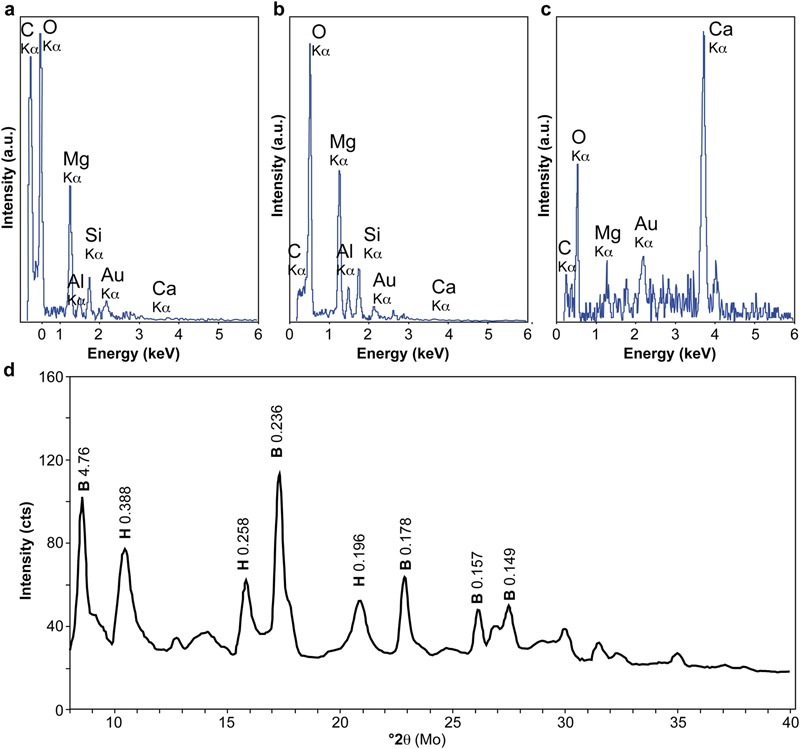
Scanning Electron Microscopy-Energy Dispersive X-ray spectroscopy (SEM-EDX) and X-Ray Diffraction (XRD) analyses of mineralized filaments from ST09 and ST07 sites. (a–c) SEM-EDX spectra of a C-rich filament (a) and encrusting O- and Mg-rich minerals (b) in ST09 samples and of secondary Ca- and O-rich minerals in ST07 samples (c). (d) X-ray diffractogram of individualized mineralized biofilament extracted by laser microdissection from an internal conduit sample of ST09 chimney. It showed the predominance of brucite (B) and minor hydrotalcite (H). Main d-spacings (in nm) are notified on the panel.